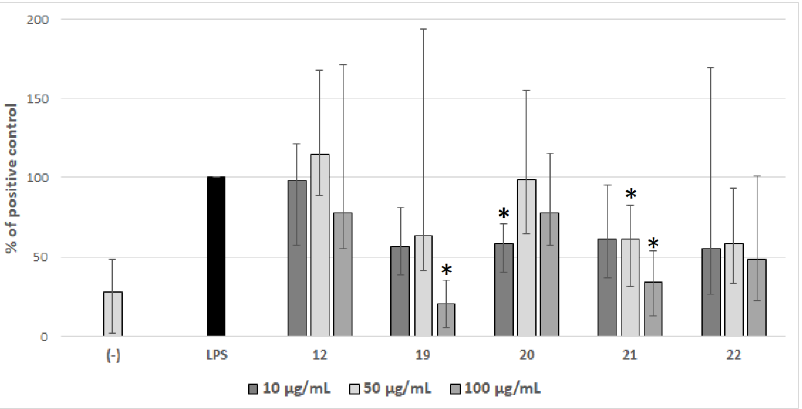
Figure 5. The effect of 12 and 19 – 22 on the LPS-induced production of INF- γ in PBMC cultures (the results are shown as percentage of positive control (LPS alone), with values expressed as medians from previous independent experiments and confidence intervals); * indicates a significant difference compared to positive control (LPS alone) at p < 0.05.